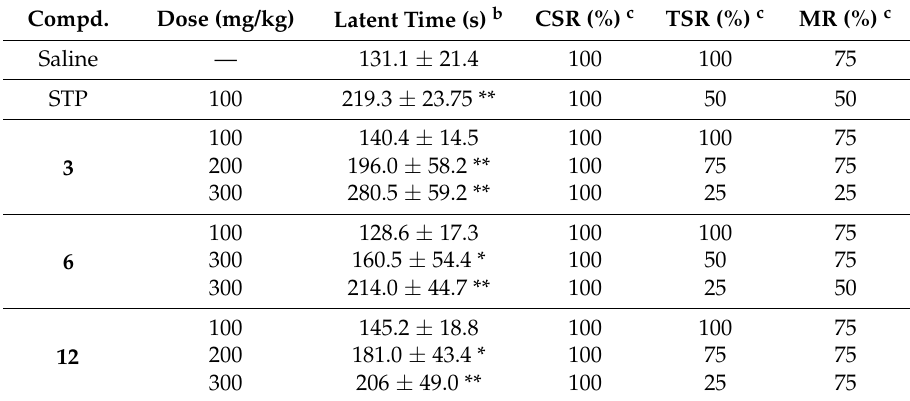
Table 2. Anticonvulsant Activity: sc PTZ Test in Mice ip a .